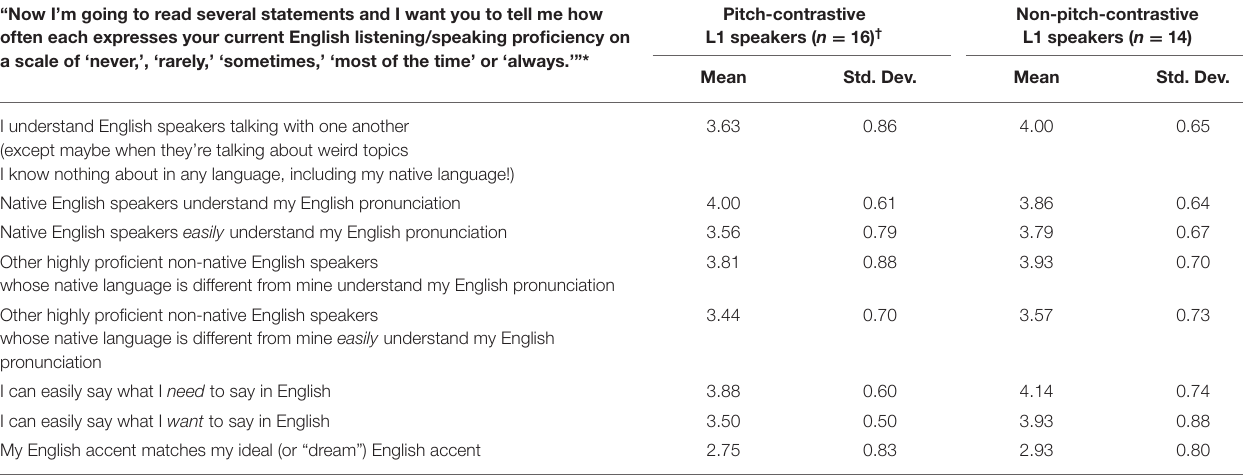
TABLE 4 | Responses to Language Background Questionnaire’s Self-Assessment of English Listening and Speaking Proficiency.